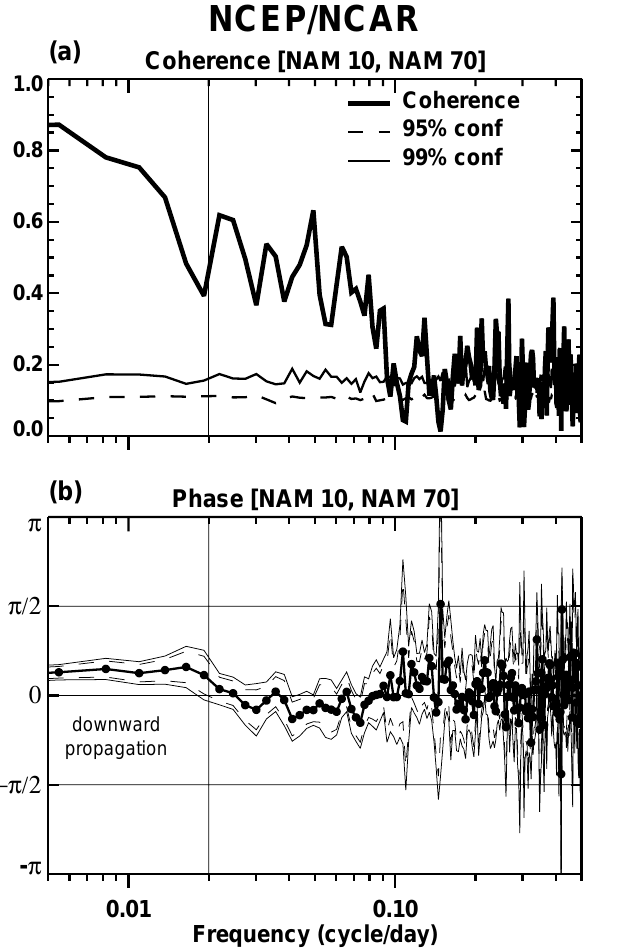
Fig. 2. Cross correlation of the NAM index at 10hPa with the NAM index at each level for (a) the 60-day low-passed NAM index and (b) the 60-day high passed NAM index. Positive contour values are solid, negative values are dotted and zero contours are dashed. The 5% (lines) and 1% (solid) significance levels are shaded. The thick black line is the position of the maximum cross correlation at each level. The NCEP-NCAR